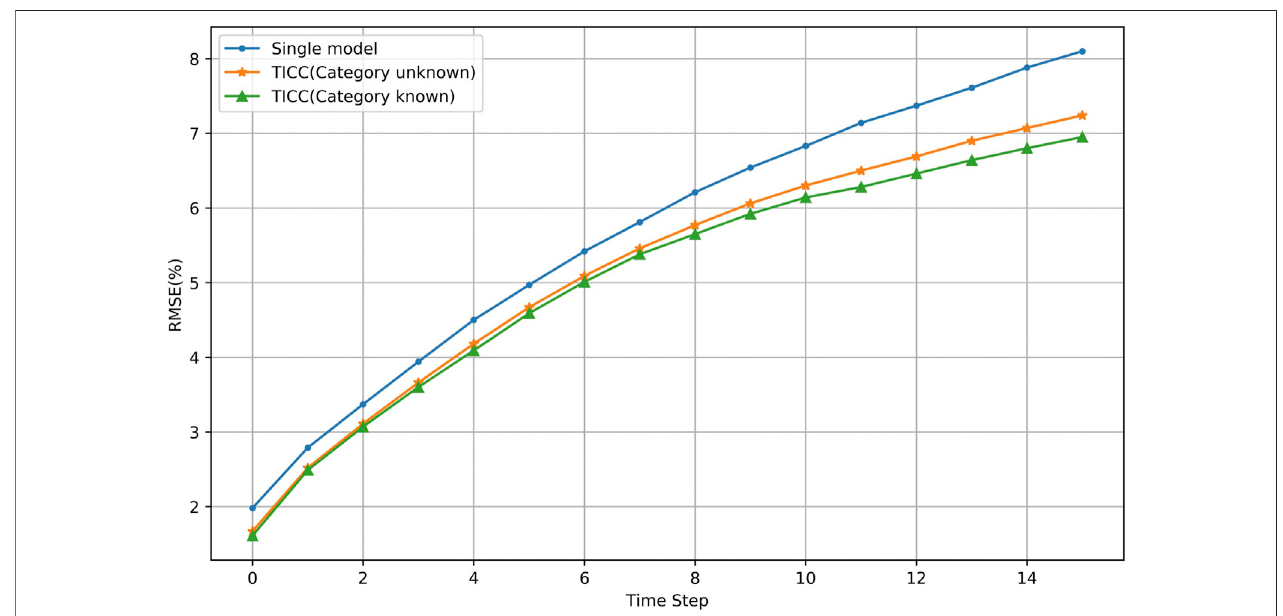
FIGURE 9 | The prediction results of TICC